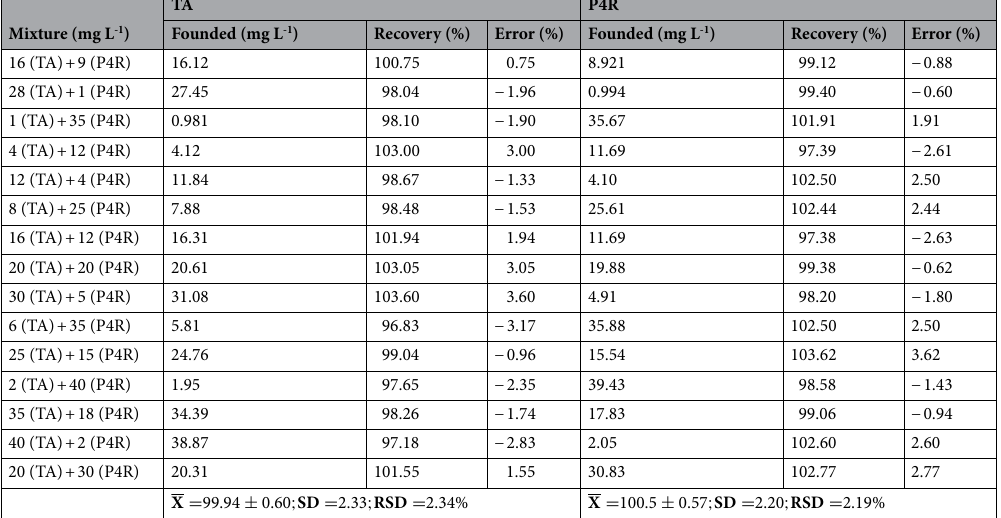
Table 2. Results of percentage recovery and error values of TA and P4R standard dye mixture by the first- order derivative spectrophotometric method. X : Mean ± SE : Standard Error; SD : Standard Deviation; RSD : Relative Standard